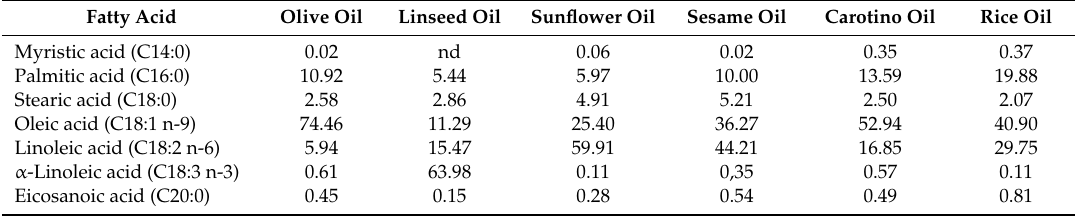
Table 2. Fatty acid composition of oils used in the experiment